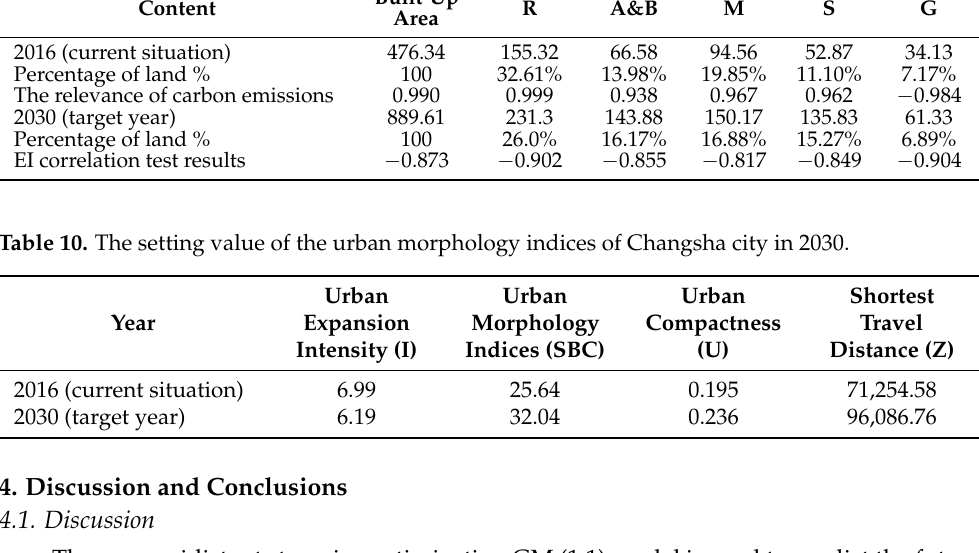
Table 9. The land constraint value of Changsha city in 2030. Content